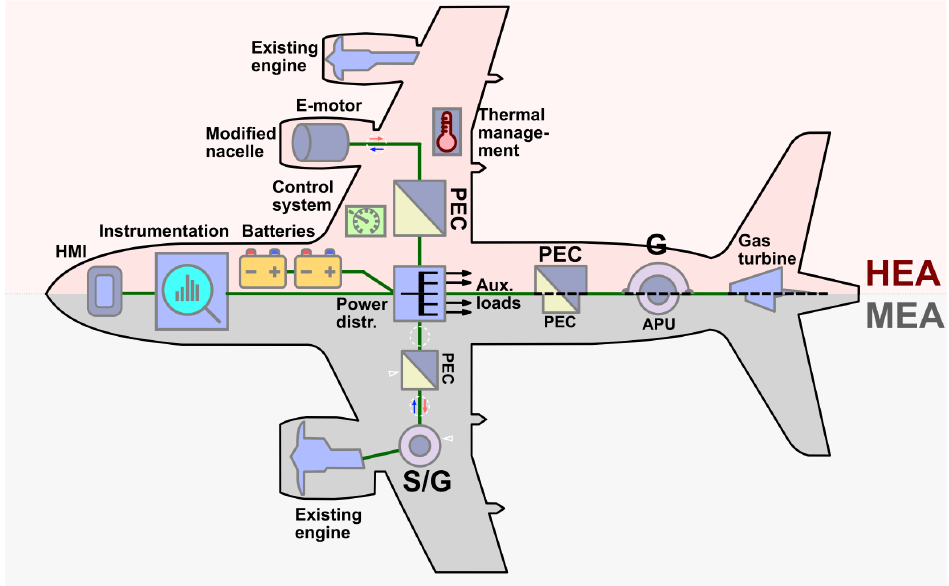
Figure 1. Side-by-side comparison of the MEA and HEA main topologies. Adapted from [11], licensed under CC BY